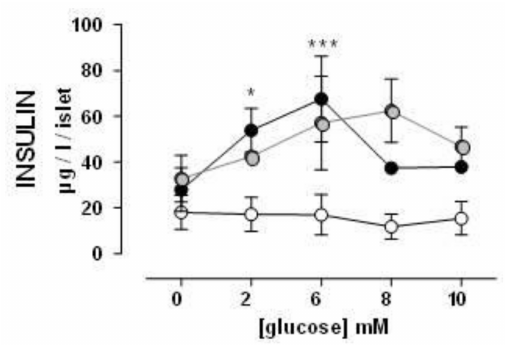
Figure 2. Insulin secretion by isolated pancreatic islets in response to the stimulus of different glucose concentrations. Experimental groups: Zucker lean rats (ZLR, white circles), control Zucker fatty rats (ZFR, black circles), ZFR treated for 12 weeks (from week 8 to week 20) with 750 mg/kg/day of the egg white hydrolyzed with pepsin (grey circles). Results are means ± SEM. Two-way ANOVA was used. * p < 0.05 and *** p < 0.001 vs ZLR ( n ≥ 9 for all